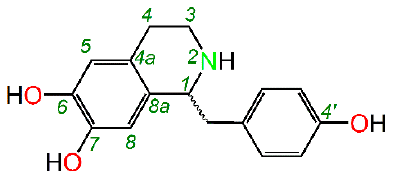
Figure 1. The structure of higenamine ( ﹏ , uncertain stereo configuration).